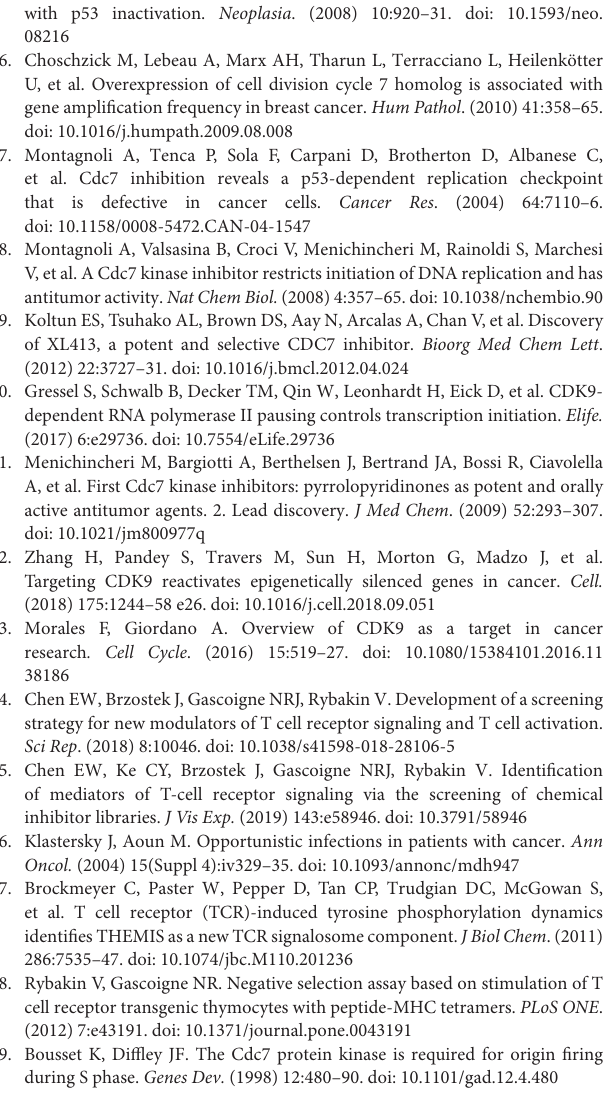
compare the percentage of active caspase-3 and CD69 expressing cells for PHA767491-treated samples to the assay controls and other inhibitors. (B,C) Chemical inhibitors of Cdc7 impair T cell activation. Peripheral lymphocytes were stimulated with plate-bound anti-CD3 antibody for 3h. Histograms depict the effect of the Cdc7 inhibitors on (B) CD69 expression and TCR downregulation and (C) the dose-response of PHA-767491 and XL-413 treatment on CD69 expression. The percentages of the positive population of each sample are represented in each graph according to their respective colors. Data shown is representative of at least three independent experiments. Figure S6 | PHA-767491 suppresses Erk phosphorylation. PHA-767491 impairs the phosphorylation of Erk in (A) OT-I CTL, (B) OT-I peripheral lymphocytes, and (C) OT-I thymocytes. The cells were treated with either DMSO or PHA-767491 and stimulated with K b -OVA tetramers for 60s. PMA was used as a positive control for Erk phosphorylation. The percentages of the positive population of each sample are represented in each graph according to their respective colors. Data shown is representative of at least three independent experiments. Bar charts, represented as mean ± SEM, have been normalized to the NS sample. Statistical significance was determined by unpaired two-sided Student’s t -test ( ∗ p < 0.05; ∗∗∗ p <